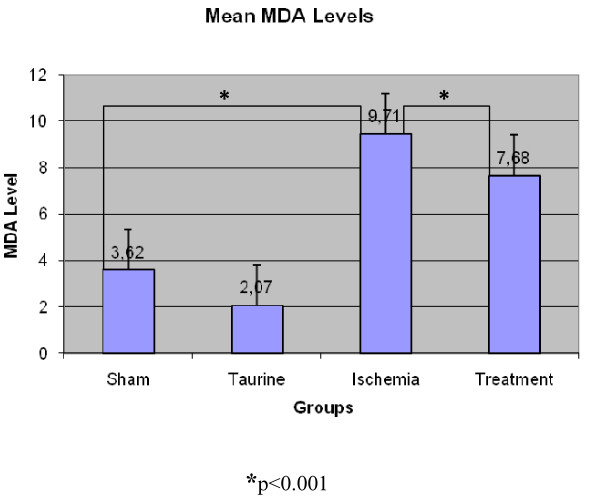
MDA levels in rat myocard tissue.